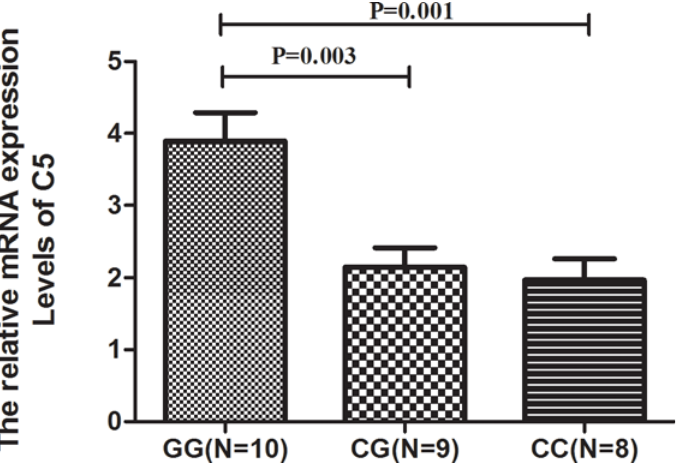
Fig 1. The mRNA expression of C5 in different genotype cases. mRNA expression of C5 in PBMCs from PDR patients with T2D carrying different genotypes of rs2269067 (GG: n = 10, CG: n = 9, CC: n = 8). Significance was analyzed by SPSS one-way ANOVA. Data are shown as mean ± SD (Standard deviation).